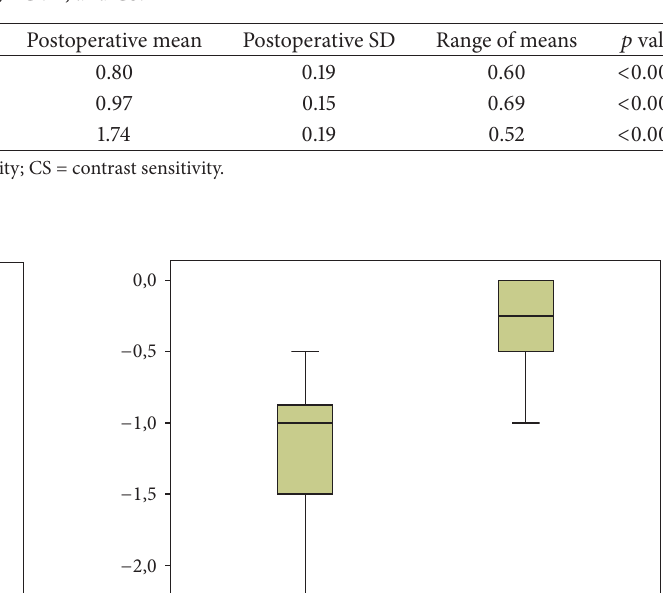
Table 2: Visual function results. There was a statistically significant difference between the preoperative and postoperative periods when the following visual functions were compared ( 𝑝 < 0.001 ): UCVA, BCVA, and CS.